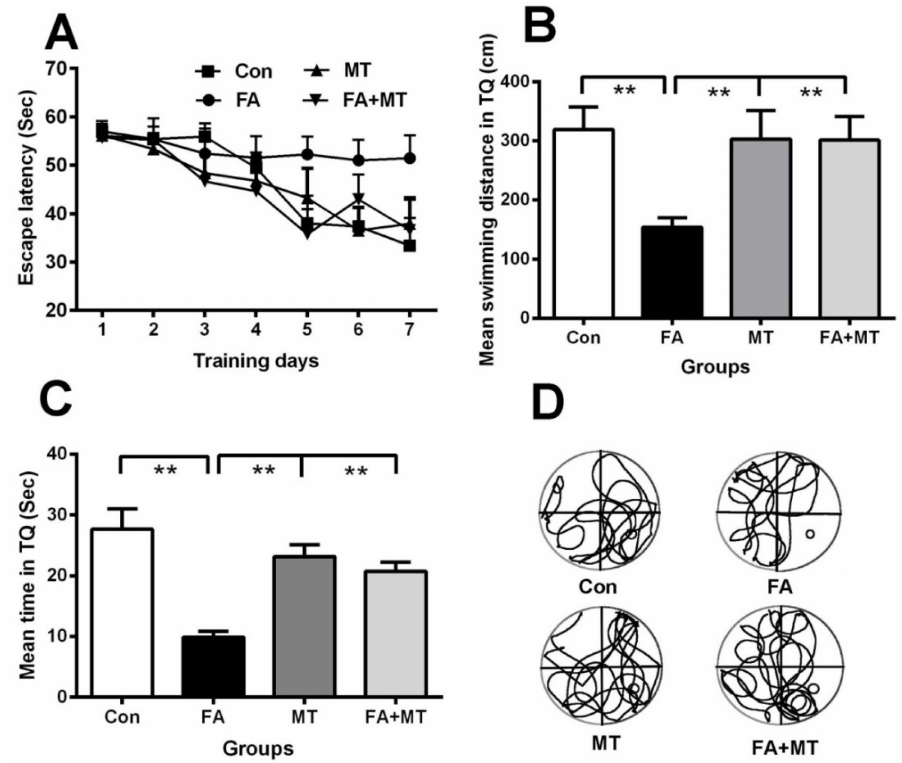
Figure 2. Injection of MT reverses gaseous FA exposure-induced spatial memory decline in mice. ( A ) Different effects of different reagents on the escape latency among control, FA exposure, MT injection alone, and FA exposure with MT (FA+MT) treated groups after 7days of spatial training ( n = 8 for each group); ( B ) Different mean swimming distances in target quadrant (TQ) in the above four groups of mice on day 8 ( n = 8 for each group); ( C ) Different mean times staying in TQ in these mice on day 8 ( n = 8 for each group); ( D ) Swimming tracks of the four groups on day 8 ( n = 8 for each group). ** p <